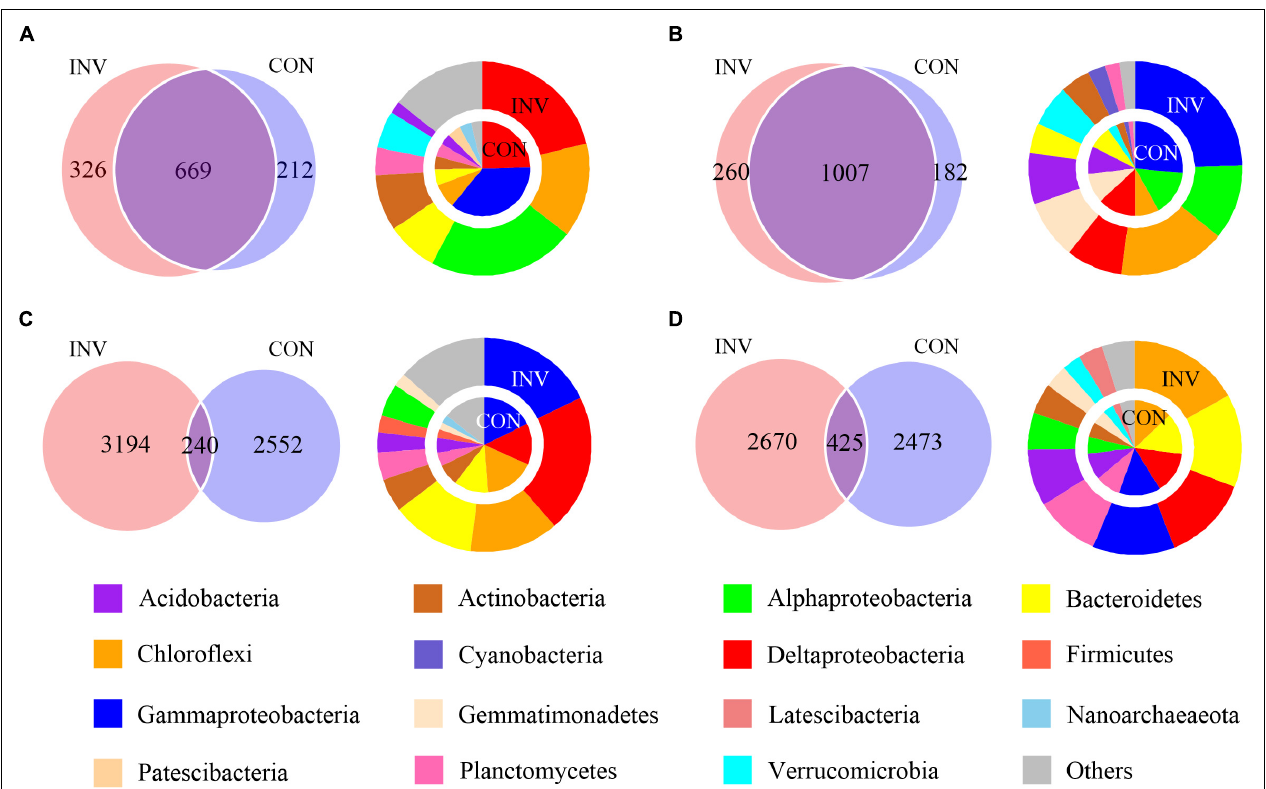
FIGURE 1 | Venn diagram representing the numbers of shared and amplicon sequence of variants (ASVs) among the CON and the INV group. The average relative abundances of the phyla (relative abundance above 2%) in each special category are shown in the pie chart. CON, the control group; INV, the invasion group. (A) Abundant taxa of the B sediment (B) Abundant taxa of the P sediment (C) Rare taxa of the B sediment (D) Rare taxa of the P